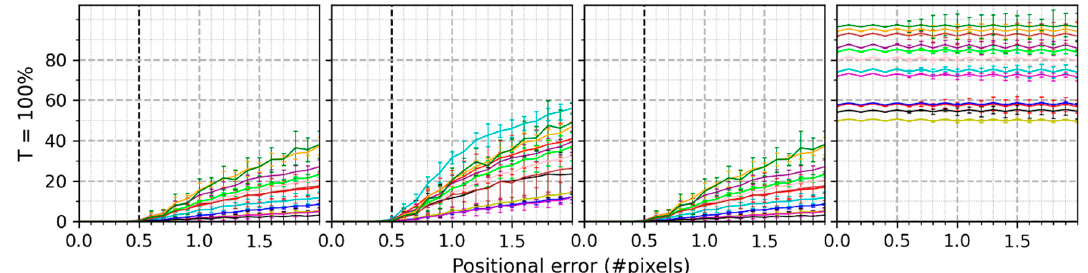
Figure 6. Mean and standard deviation of OA − error , Kappa − error , AD − error , and APAU of four spatial scales at different study sites where the classification scheme consists of 15 classes.